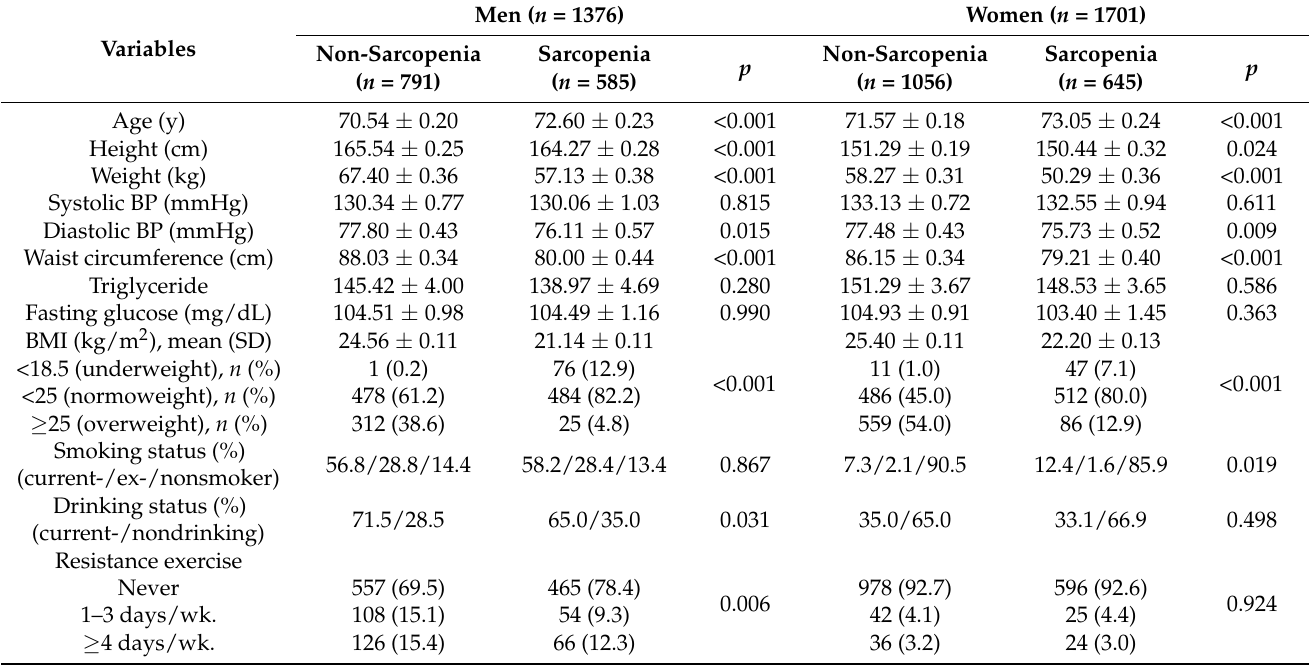
Table 2. Characteristics of participants stratified by sex according to